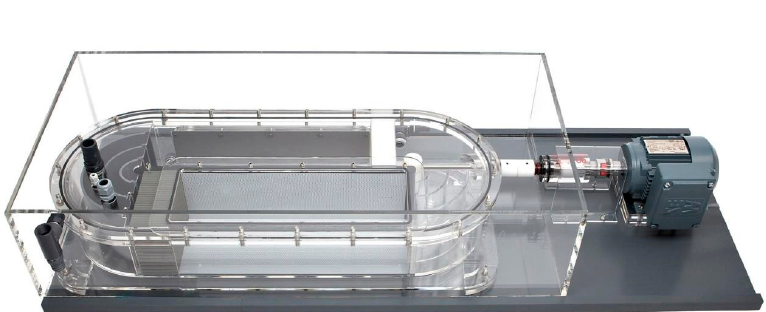
Figure 2. Loligo swim tunnel (https://www.loligosystems.com, (accessed on 10 May 2020).